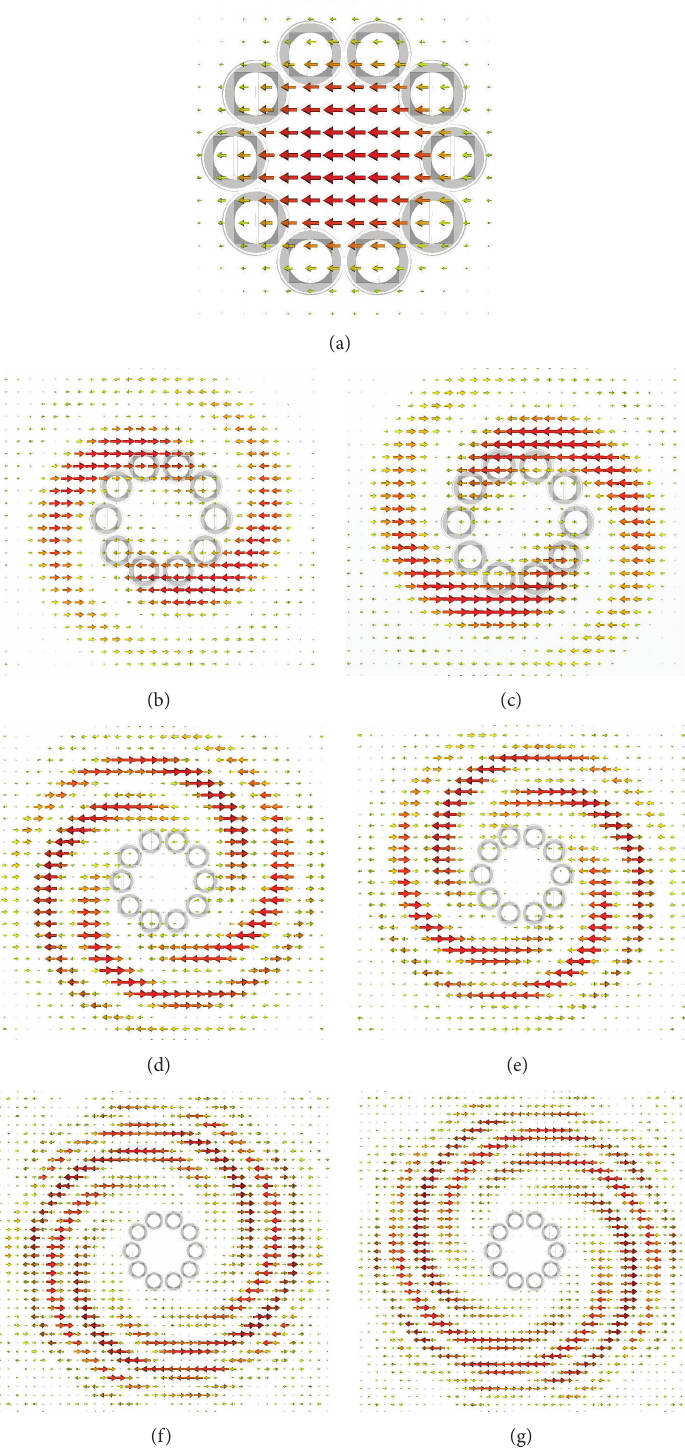
Figure 10: The vectors of electric field for linear polarization with different OAM states. (a) ℓ = 0 , (b) ℓ = +1 , (c) ℓ = −1 , (d) ℓ = +2 , (e) ℓ = −2 , (f) ℓ = +3 , and (g) ℓ = −3